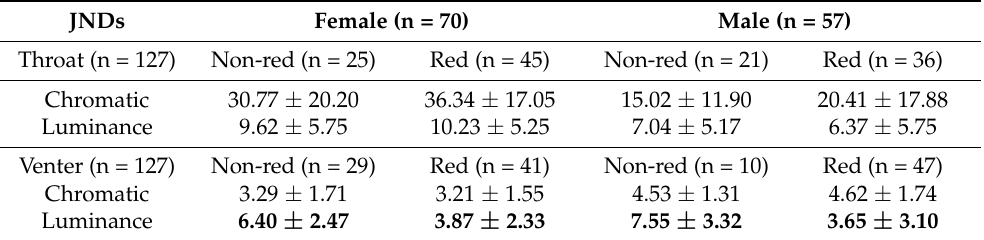
Figure 4. Conspicuousness of S. crocodilurus ’ colour in just-noticeable differences (JNDs) in relation to a lizard visual system for chromatic and luminance channels against a green leaf background. ( a ) Chromatic and luminance contrast of colour patch by sex and body region. ( b ) Chromatic and luminance contrast of throat colour patch by colour variant (red, no-red) and sex. ( c ) Chromatic and luminance contrast of ventral colour patch by colour variant (red, no-red) and sex. “*” indicates a significant difference. Black points in the figure show the outliers of conspicuousness. Table 1. Comparisons of means and standard deviations for chromatic and luminance contrast (JNDs) for red and non-red colour variants against background vegetation under a lizard visual system for each sex. Bold indicates significant difference ( p < 0.05) between two colour